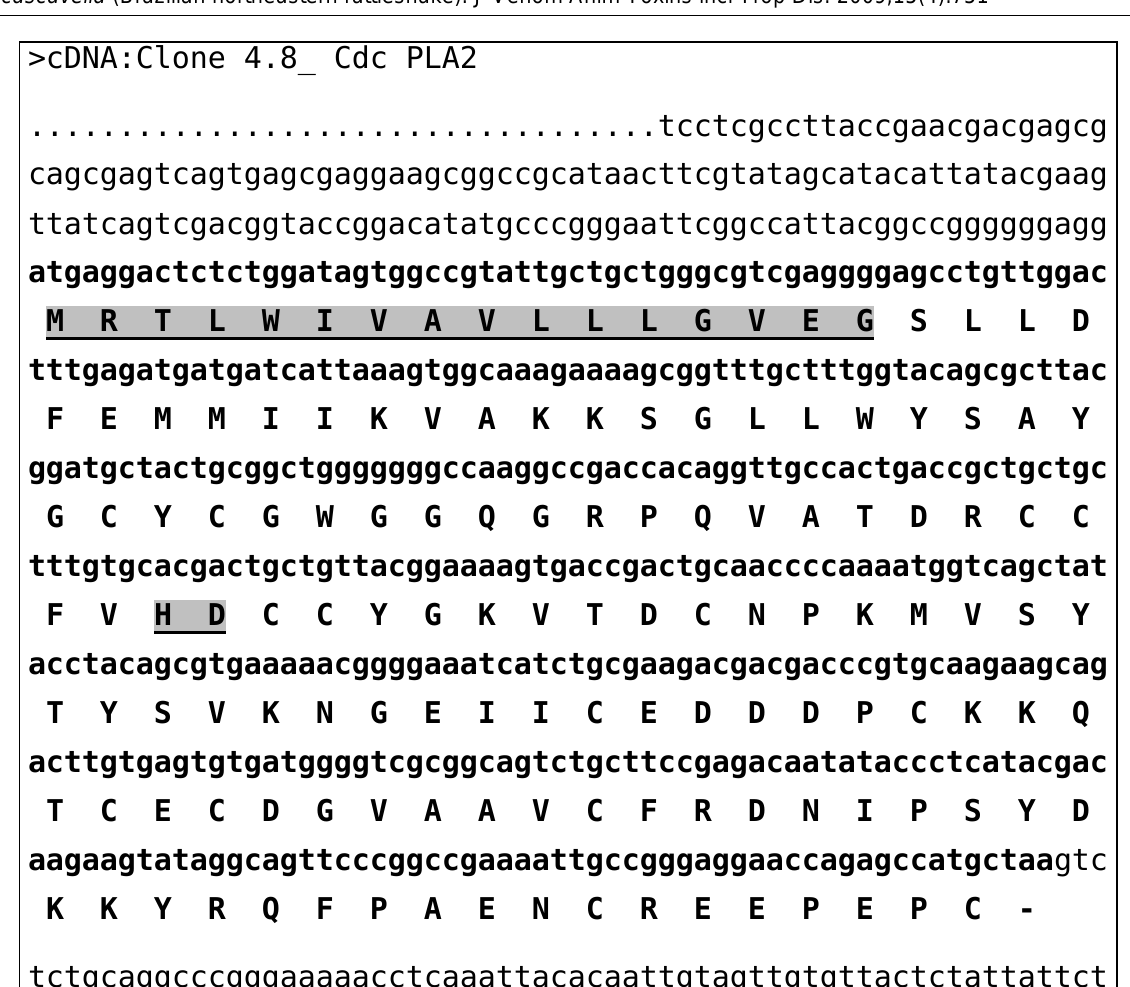
Figure 1. Nucleotide and amino acid sequences of a novel PLA venom gland of C. d. cascavella ( Cdc ). The Cdc - PLA number GQ466583) is composed of 689 nucleotides, with an open reading frame (ORF) of 453 nucleotides, which is shown in bold lower-case letters. The ORF encodes a precursor of 138 amino acid residues, shown in a single letter code. The signal peptide of 16 residues is boxed in gray and the residues His48 (H) and Asp49 (D) of catalytic and calcium binding sites, respectively, are underlined in a gray